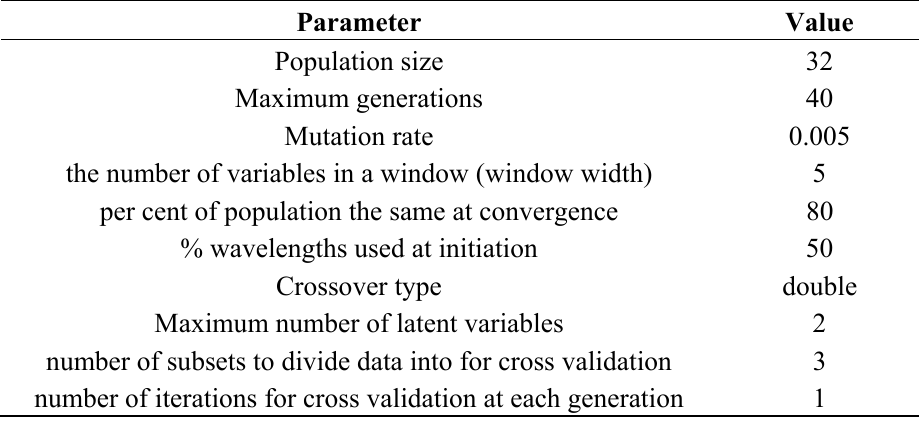
Table 2. Optimum parameters of the genetic algorithms